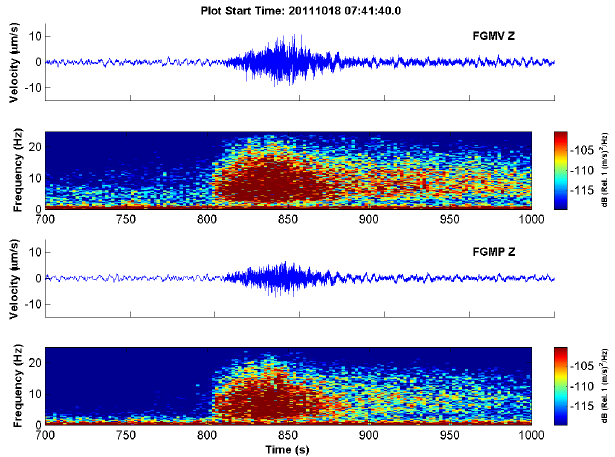
Fig. 7. Example of a spasmodic tremor episode, which lasted for about 2h, recorded a few minutes after the cigar-shaped event of the Fig. 6. As with the the previous figure, the seismograms and spectrograms are of the vertical component of the stations FGMV (top) and FGPP (bottom). The spectrograms were computed with the same method as the Fig. 6.